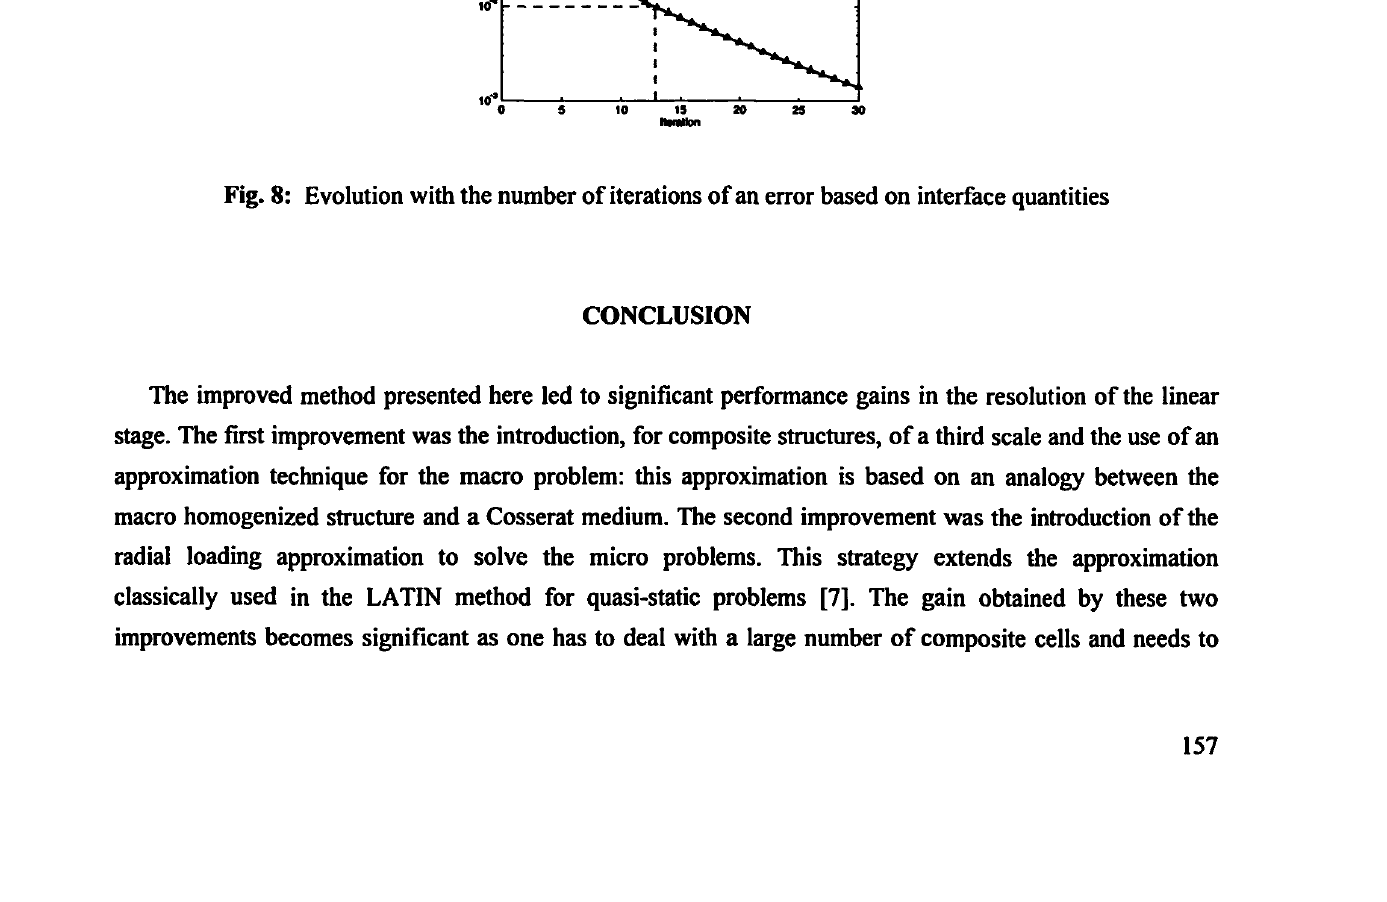
Fig. 8: Evolution with the number of iterations of an error based on interface